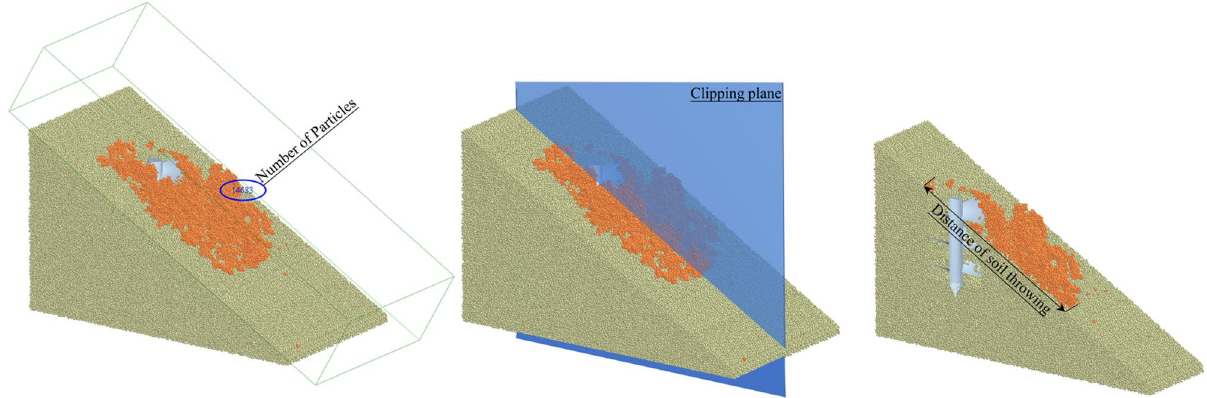
Figure 6. Acquisition of simulation